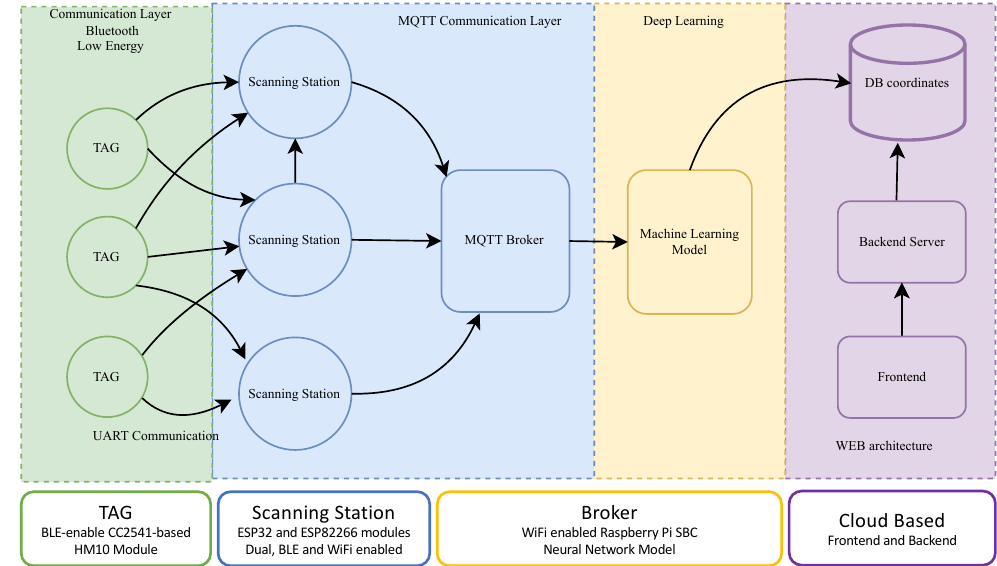
Figure 1. Architecture of the IoT solution for indoor localization based on RSSI fingerprinting (taken from